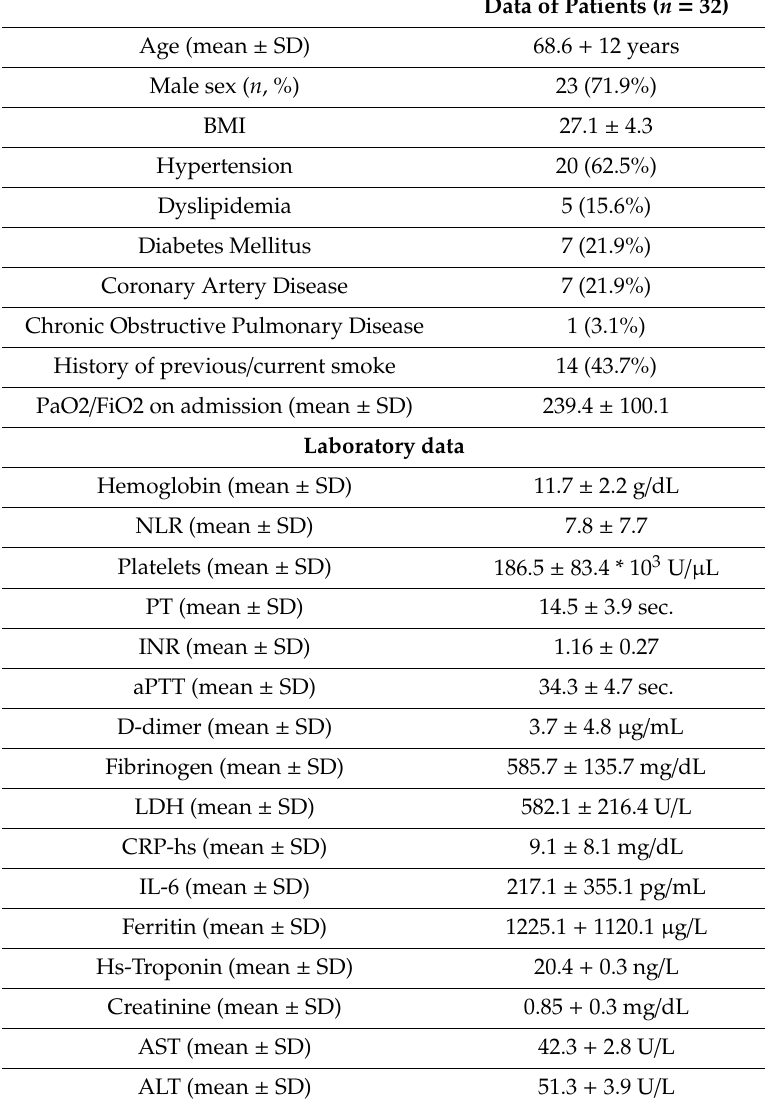
Table 2. Demographics, clinical, and laboratory data of patients of the case